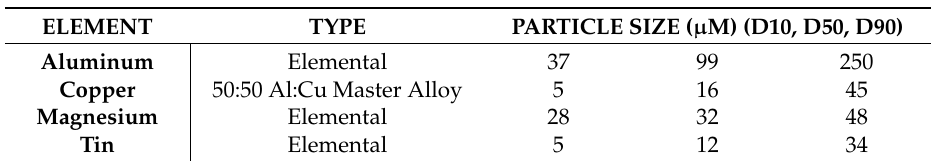
Table 1. Overview of the metallic powders